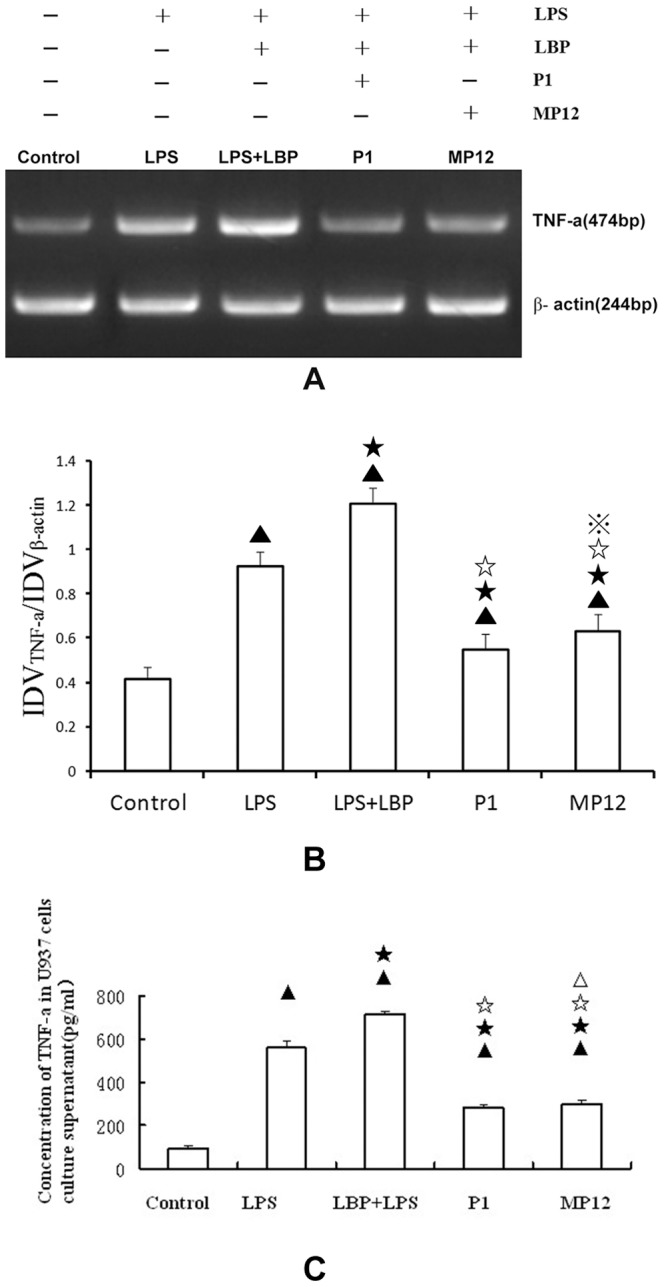
Effects of polypeptides P1 and MP12 on LPS-induced TNF-α mRNA expression and secretion by U937 cells.A. Agarose gel electrophoresis results for TNF-α mRNA expression by RT-PCR. B. The optical density ratio for target gene/β-actin was determined. Results are means ± standard deviations. C. Cell culture supernatant was used to detect the concentration of TNF-α(with ELISA) ▴ compared with the control: P<0.01; ★ compared with LPS treatment: P<0.01; ☆ compared with LPS+LBP treatment: P<0.01;  compared with P1 treatment: P<0.05; ▵ compared with P1 treatment:P<0.01.